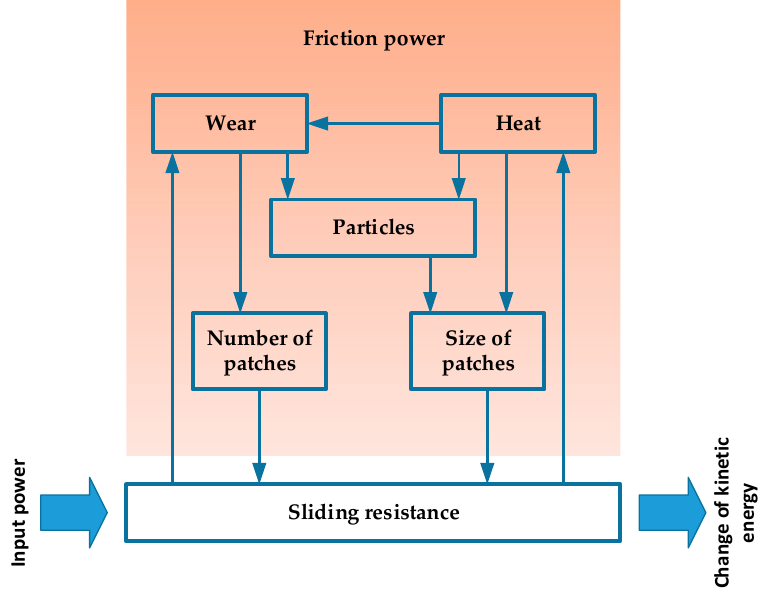
Figure 2. Energetic balance involving friction phenomena, as proposed in [17]. Reprinted with permission from [17]. Copyright Elsevier, 2003.